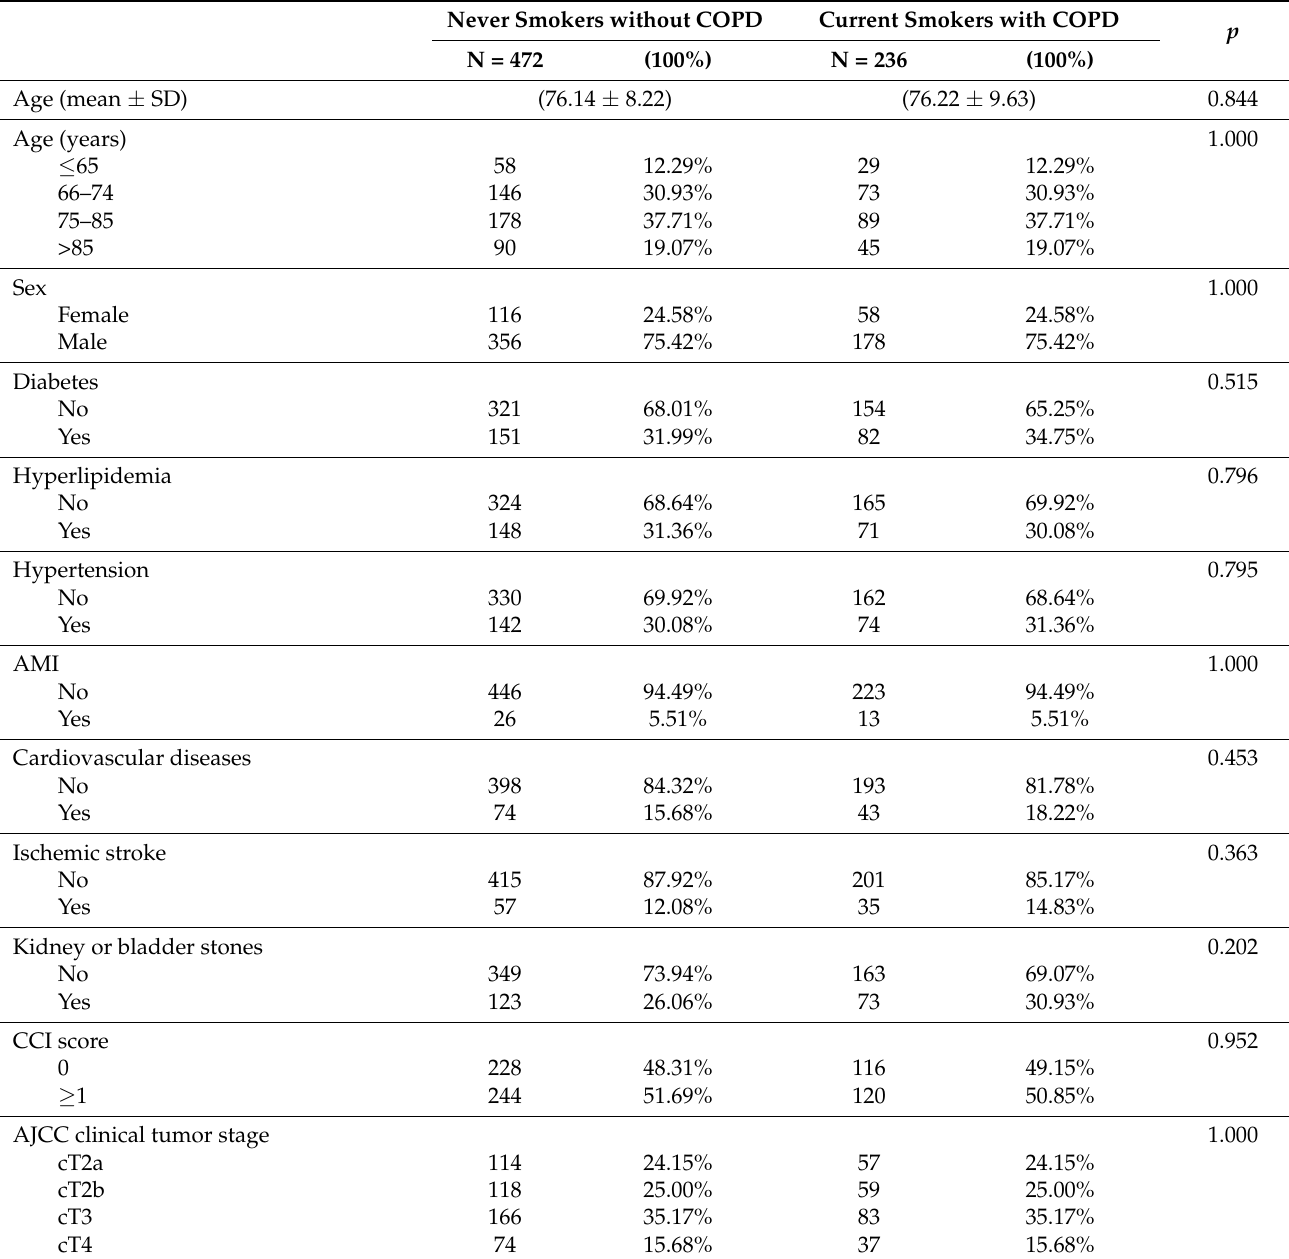
Table 1. Characteristics of propensity score-matched patients with muscle-invasive urothelial carcinoma of the bladder with and without current-smoking-related COPD before definitive CCRT for bladder